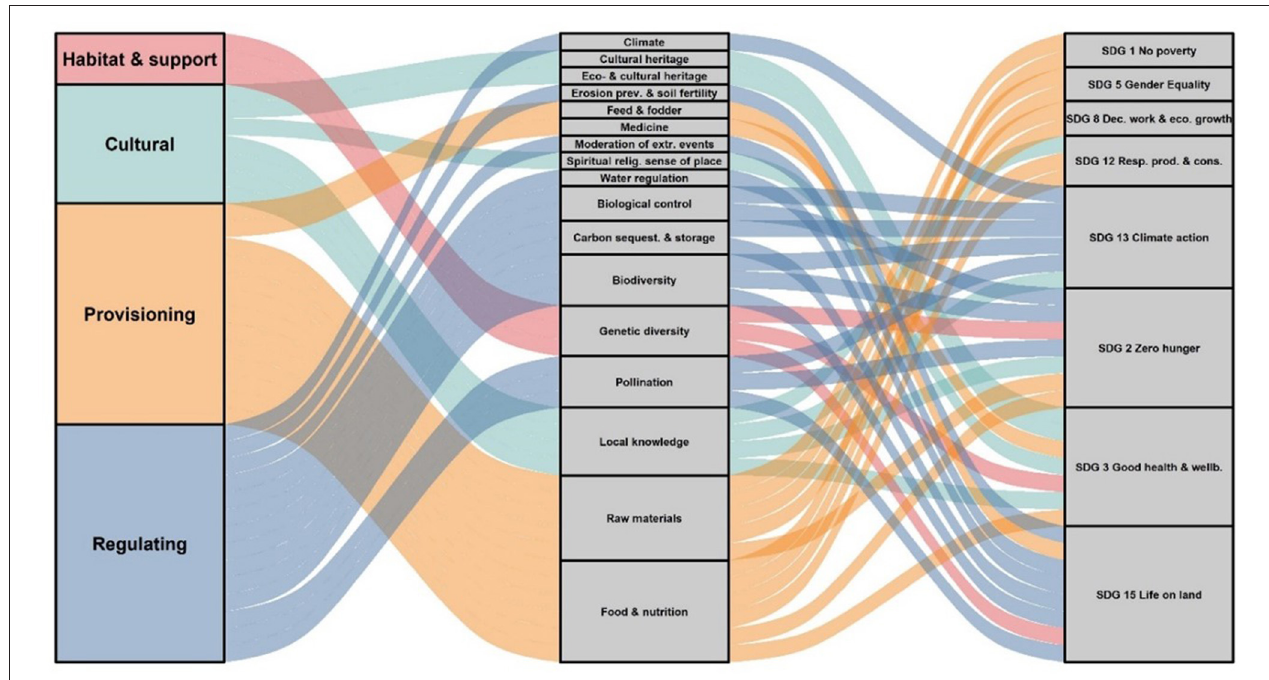
FIGURE 3 | Perceived contribution of ecosystem services provided by NUS to the SDGs: Based on our findings, we deduced that NUS have the potential to contribute to the fulfillment of eight SDGs. The height of a block is proportional to the number of ecosystem services included in the cluster, and the width of a stream field is proportional to the number of ecosystem services included in both clusters connected by the